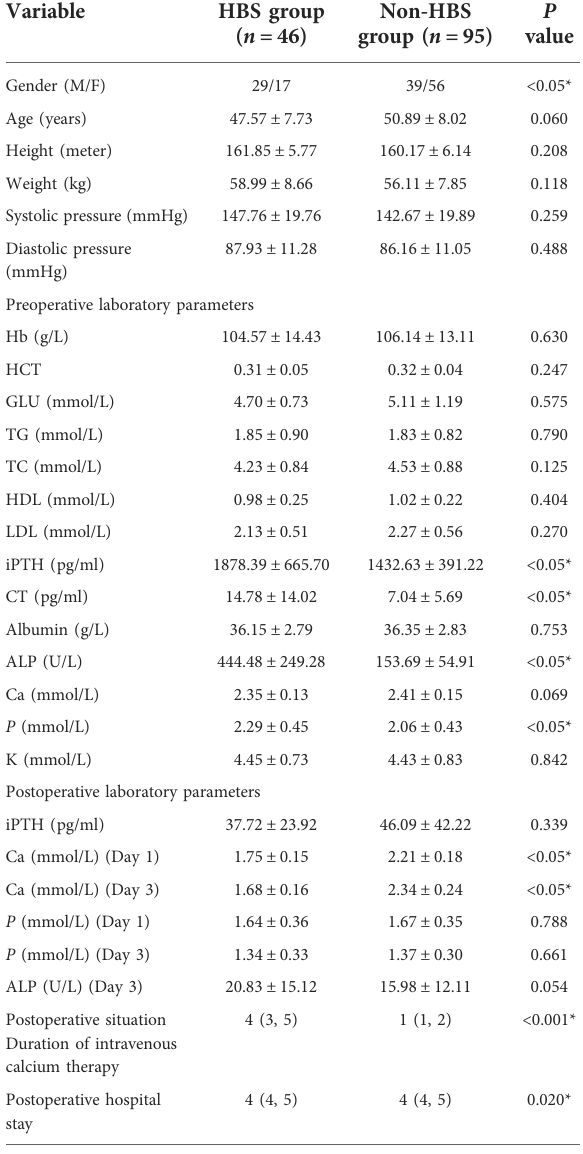
TABLE 1 Comparison of preoperative and postoperative demographic and laboratory data in maintenance dialysis patients with PTX+AT.